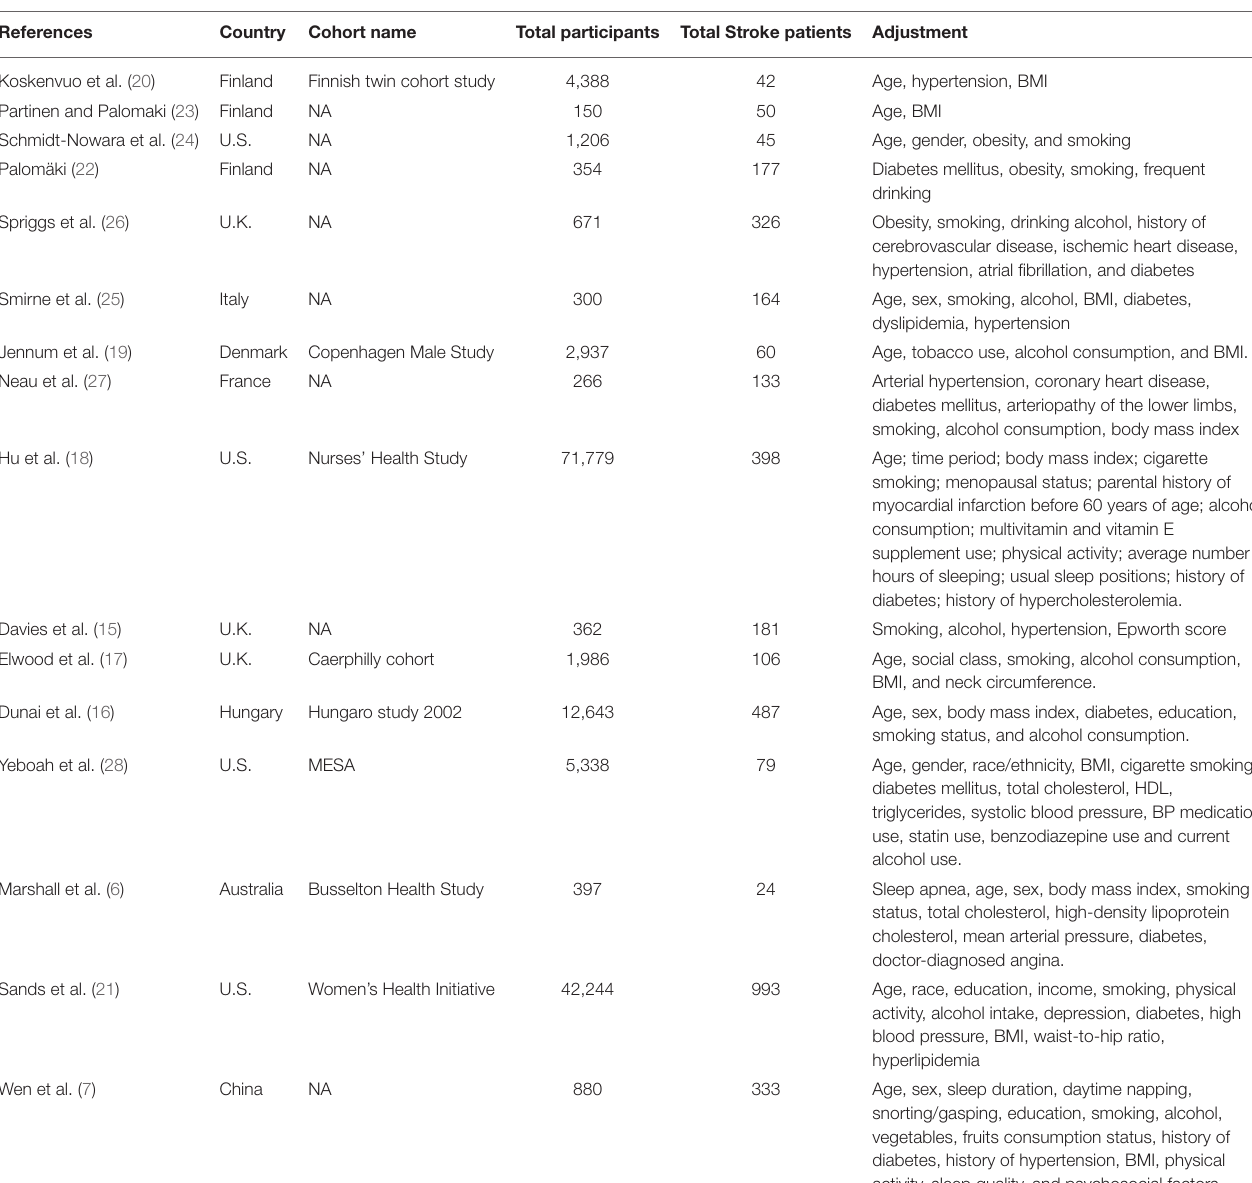
TABLE 1 | Characteristics of included